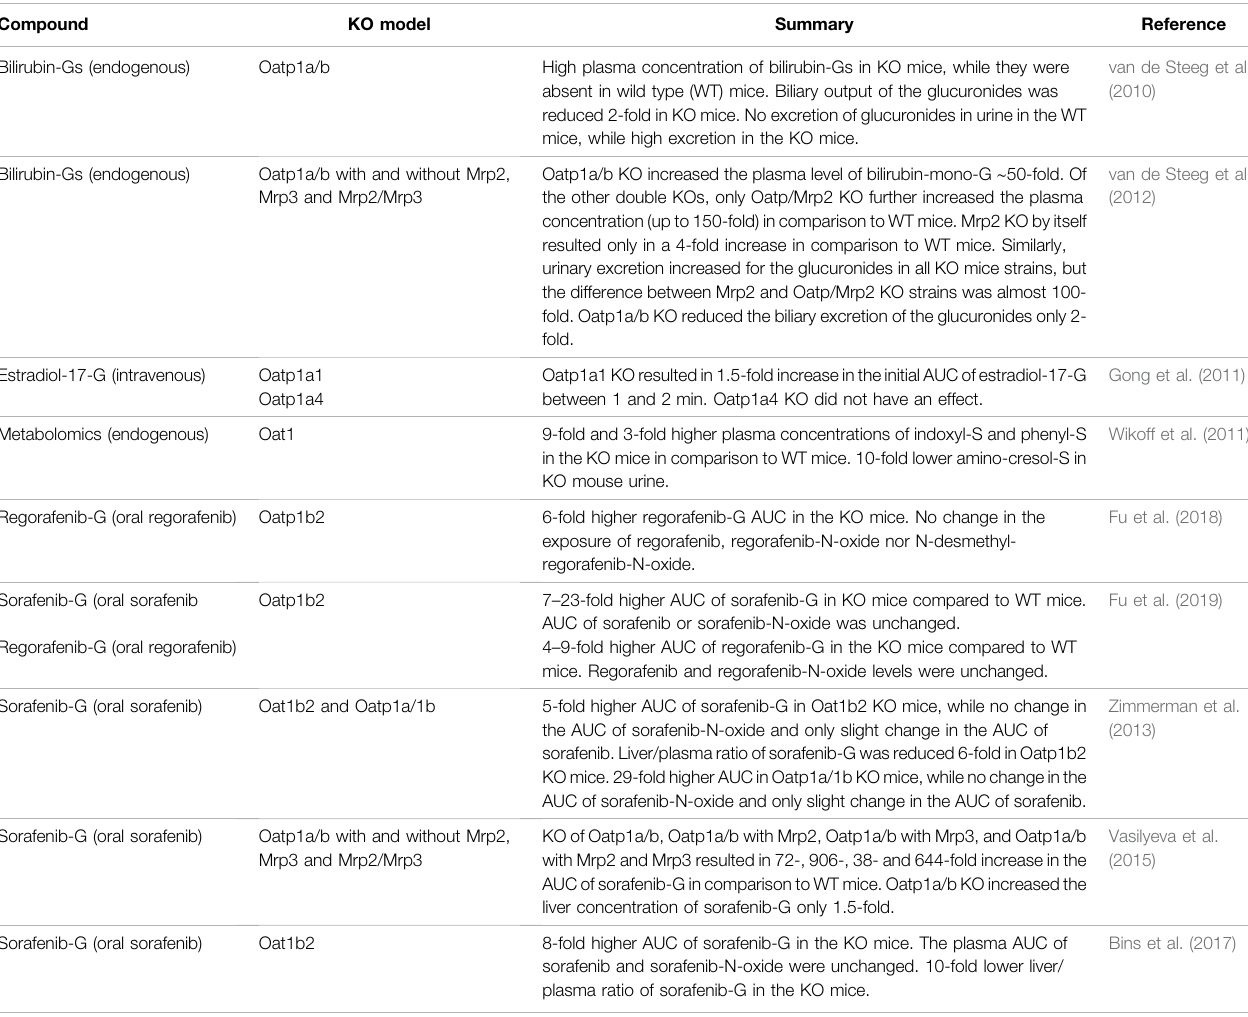
TABLE 4 | Studies in knockout (KO) mice supporting the signi fi cance of uptake transporters in the disposition of glucuronide and sulfate metabolites of drugs and other compounds.